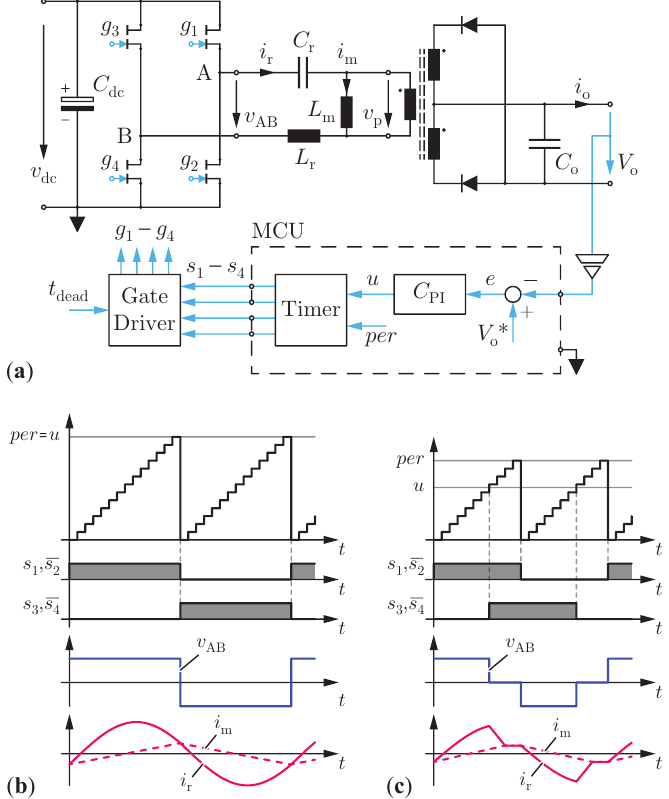
Figure 4. ( a ) Proposed control topology for the DC/DC converter, with output-voltage regulation by variable frequency using only an isolated low-voltage measurement and a low-cost, 32-pin ST Arm Cortex M4 as the MCU. ( b ) Continuous conduction mode (CCM) operation, where the digital PI s 4 . ( c ) When the control variable ( u ) is controller adjusts the period of the MCU timer to trigger s 1 − lower than the minimum (user-defined) switching period ( per ), the converter enters discontinuous conduction mode (DCM), with a fixed frequency and a variable phase-shift to control the output voltage to the reference value ( V o